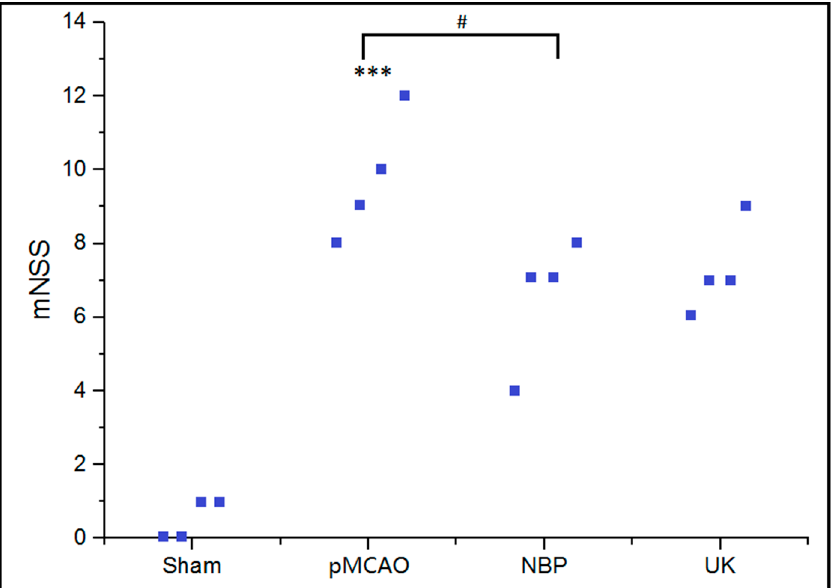
Figure 2. The modified neurological severity score of various groups. Sham: sham surgery group; pMCAO: permanent middle cerebral artery occlusion (pMCAO) group; NBP: dl-3-n-butylphthalide-treated group; UK: urinary kallidinogenase-treated group. *** p < 0.001, the pMCAO group compared with the sham group; # p < 0.05, the NBP group compared to the pMCAO group. n = 4.